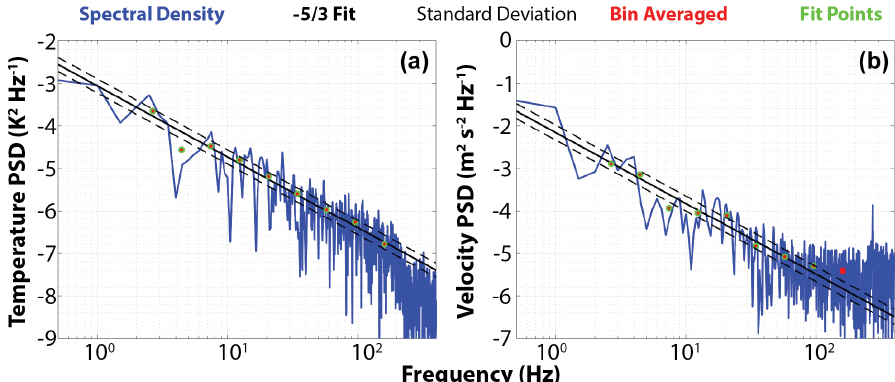
Figure 4. Spectral fitting process for estimating turbulence parameters fits an inertial cascade model (black line) to the raw spectral data (blue line) by first averaging over fractional decade frequency bins (red dots), using a subset (green dots) that are free of artifacts. Cold-wire temperature (a) is used to estimate temperature structure constant C 2 , and hot-wire velocity (b) is used to estimate TKE dissipation rate ε . T Data from the IDEAL campaign, sortie 28, flight 62, deployed at 06:30LT on 13 November